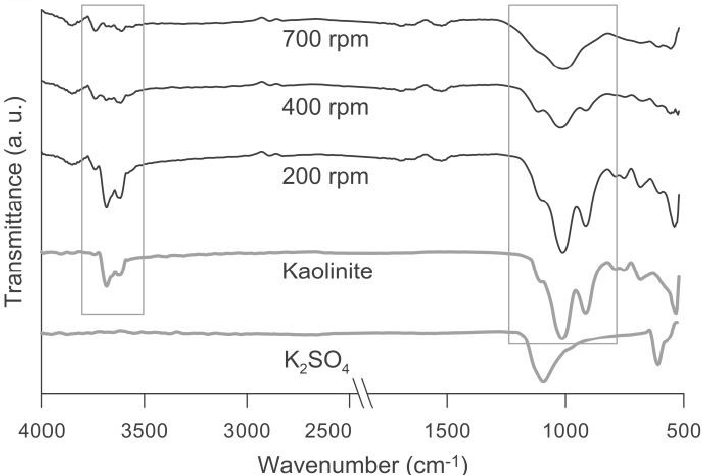
Figure 5. FTIR spectra of kaolinite-K 2 SO 4 samples milled at different rotating speeds for 120 min.